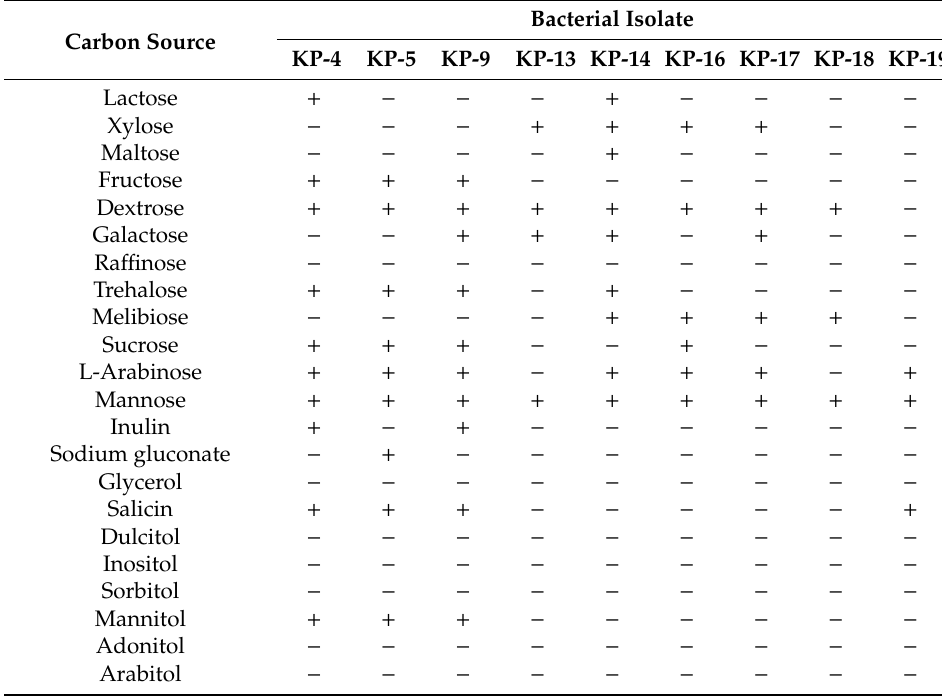
Table 2. Carbon utilization profile of di ff erent bacterial isolates determined by Hi-Carbo Kit (HiMedia, Mumbai, India). + indicates positive (observed) use; − indicates negative